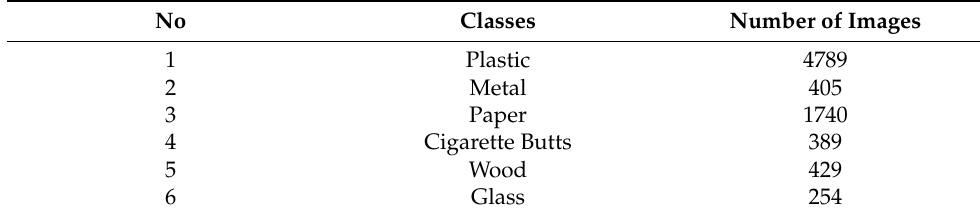
Table 2. Numbers of each sample.